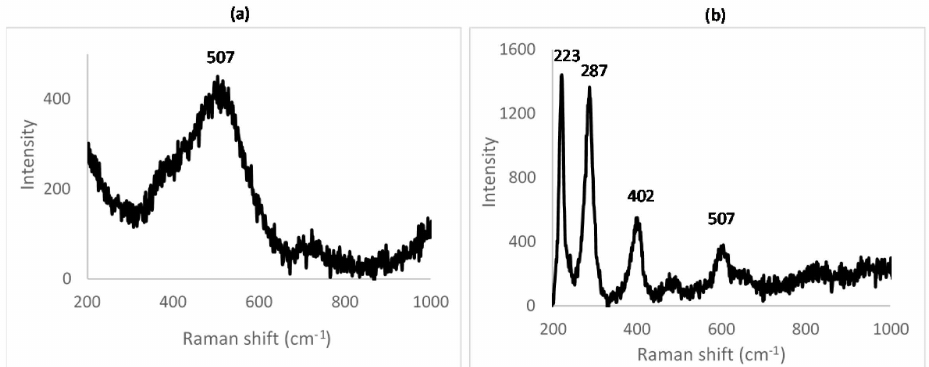
Figure 5. Raman spectrum obtained for ( a ) NiO and ( b ) Fe 2 O 3